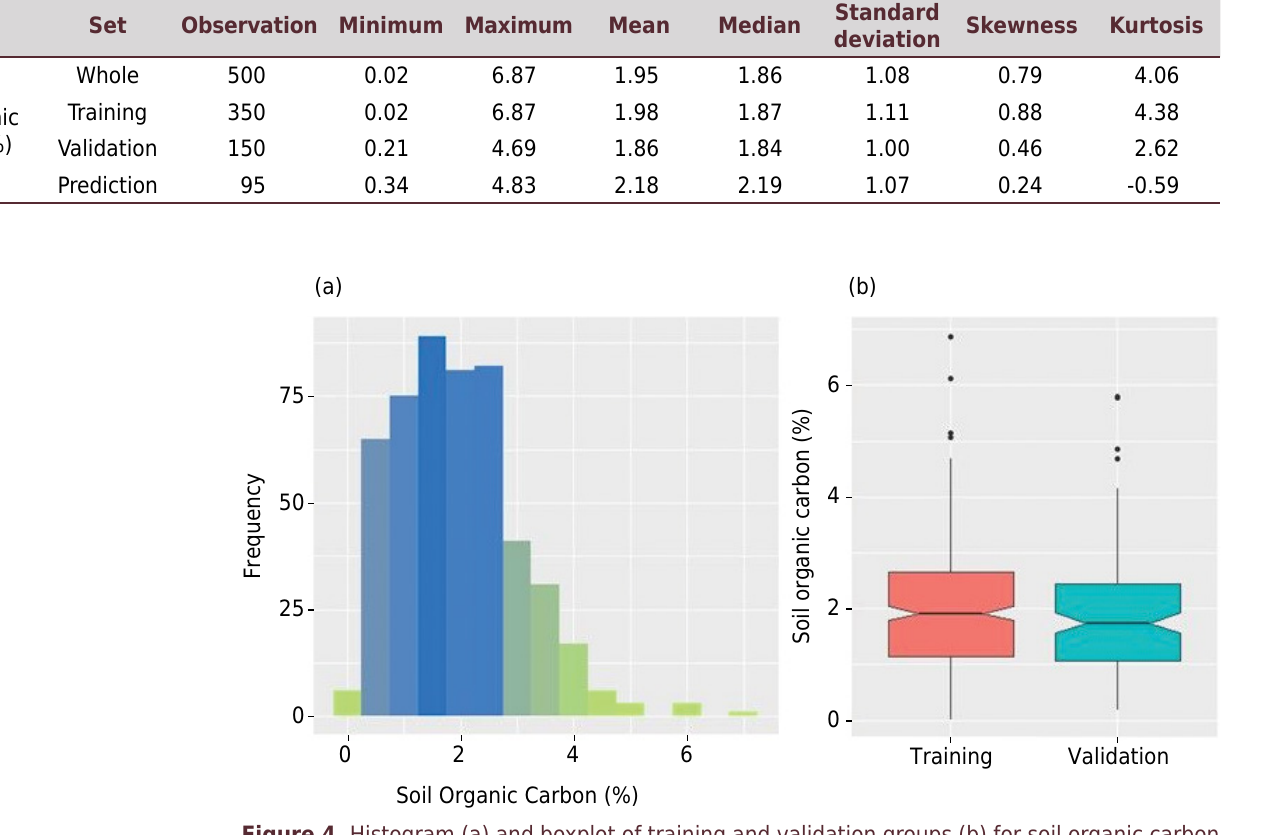
Figure 4. Histogram (a) and boxplot of training and validation groups (b) for soil organic carbon performed in